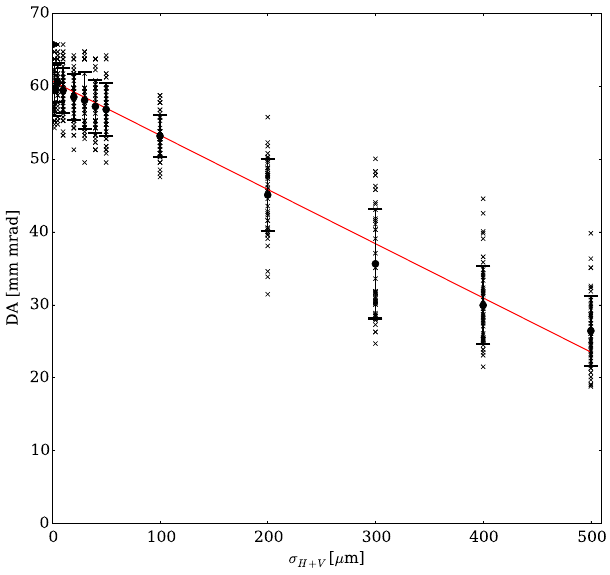
FIG. 9. The DA as a function of horizontal and vertical cell misalignments with a Gaussian distribution of width σ . Each individual randomly offset lattice is shown as a cross, the mean is shown as a filled circle, and the standard deviation as the error bars. The red line shows a minimum chi-squared fit to the